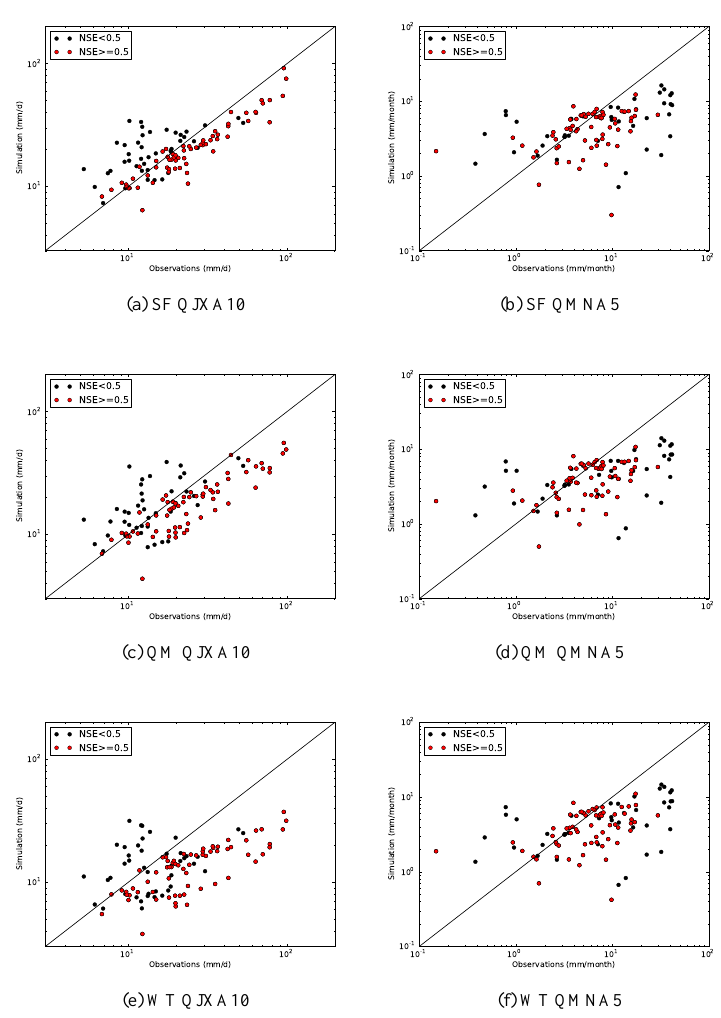
Fig. 9. Comparison of the simulated (using SAFRAN/F as atmospheric forcing) and observed QJXA10 and QMNA5. Each dot corresponds to a gauging station. The calculations were made with stations with at least 15 full yr of observed data. Red dots represent the stations that the model simulates reasonably well (NSE > 0 . 5), black dots correspond to the rest.